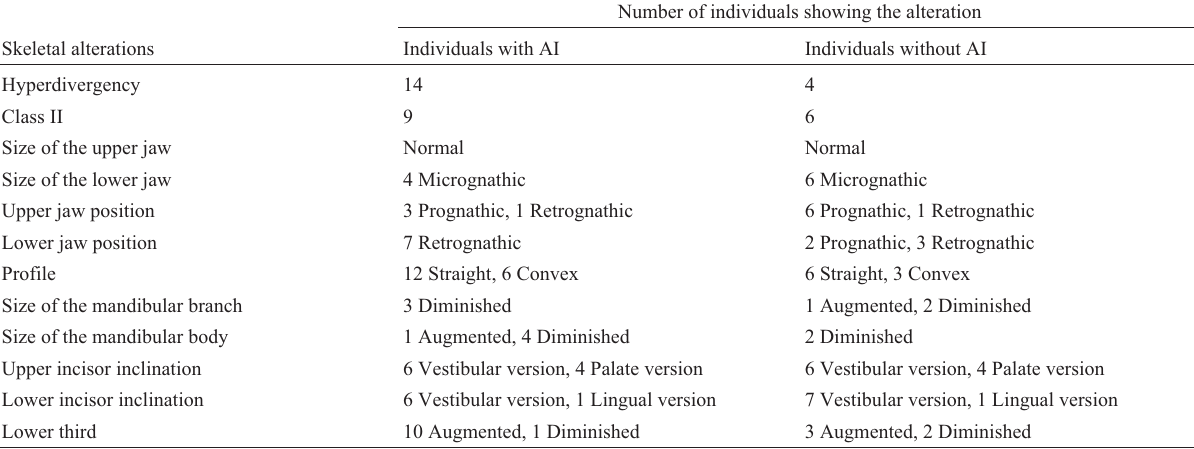
Table 4 - Skeletal alterations in patients with and without